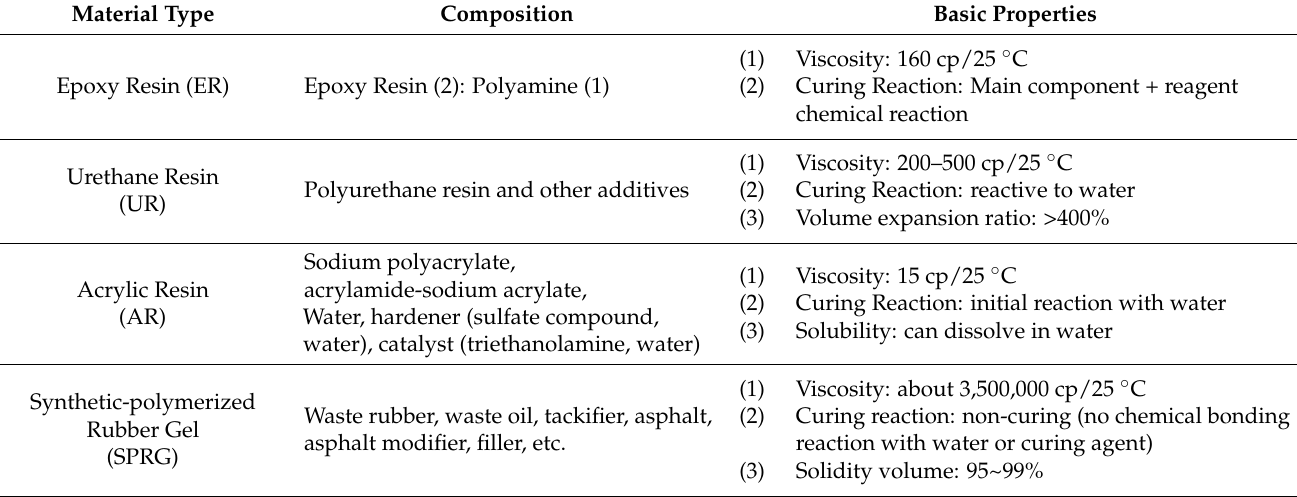
Table 1. Specimen (material)